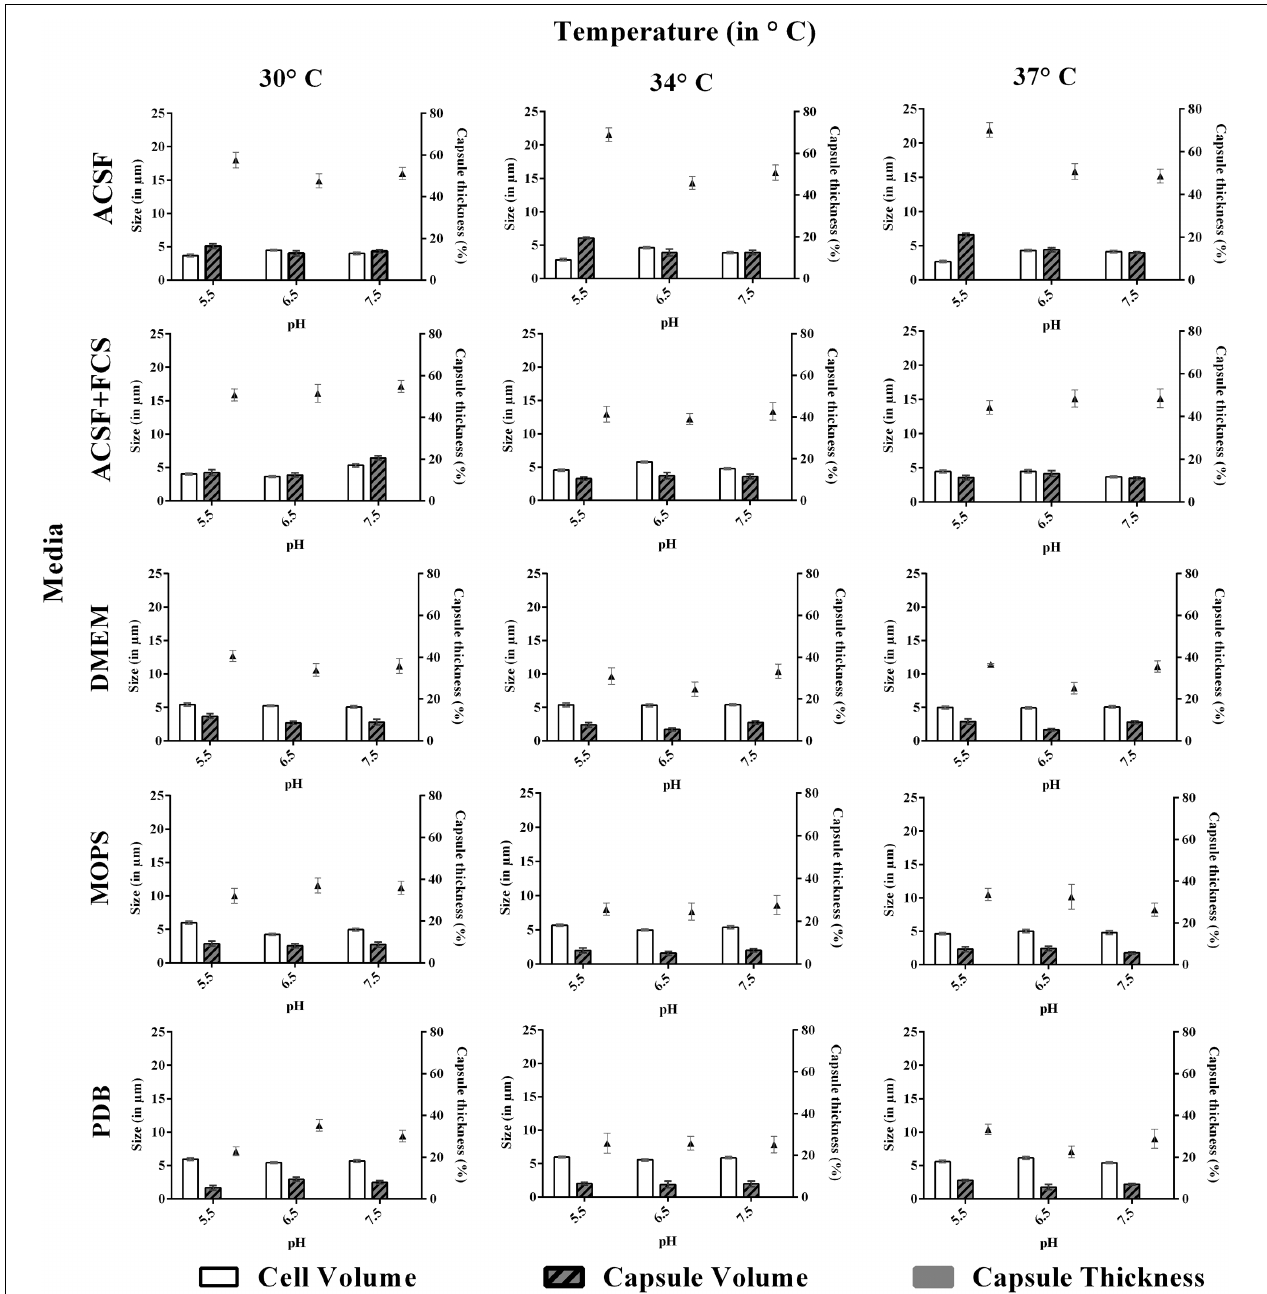
FIGURE 4 | Effect of pH and temperature on capsule induction in clinical C. neoformans in different media at 72 h. Left Y -axis represents size (in µ m) for cell and capsule, compared with capsule thickness (in %) through right Y -axis. The cell size, capsule size and percentage of the capsule thickness for ≥ 8 cells per group are shown. Bars represent standard errors ( p <